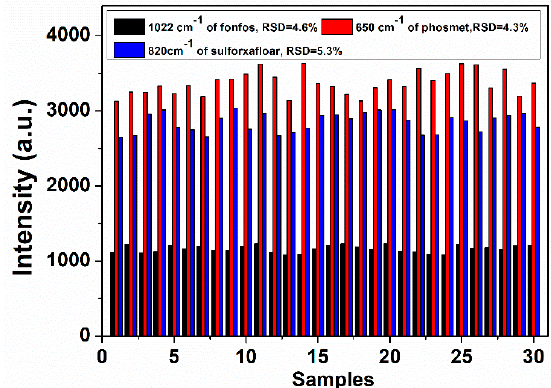
Figure 4. The intensity deviation of the peak at 1022 cm − 1 for 2 mg/L fonofos (black), the peak at 650 cm − 1 for 5 mg/L phosmet (red), and the peak at 820 cm − 1 for 10 mg/L sulfoxaflor (blue). The selection of representative peaks was based on the intensity.